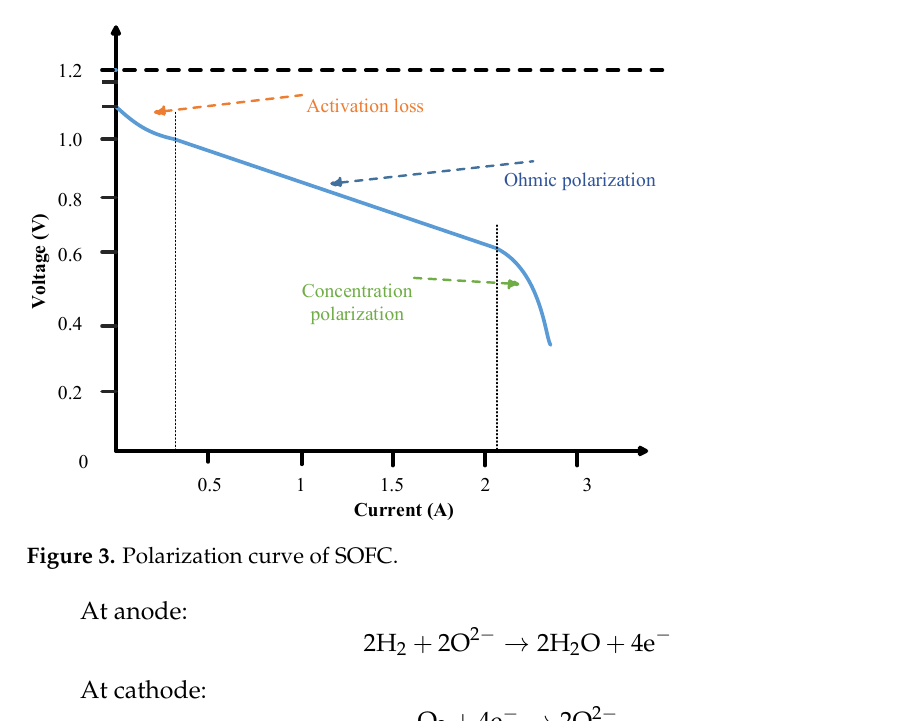
Figure 2. Electrochemical operation mechanism of SOFC [17].